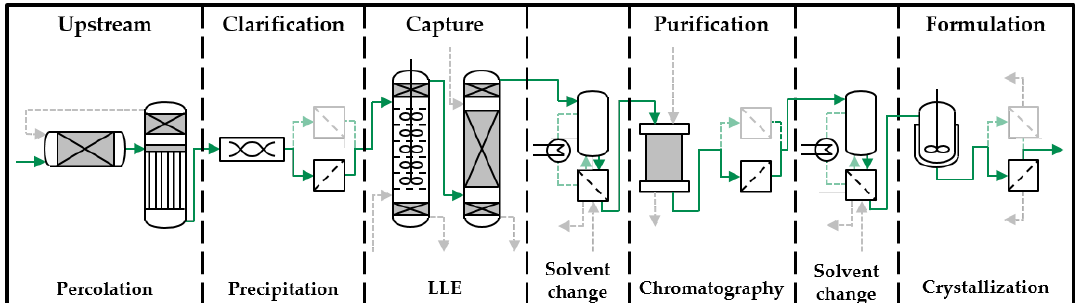
Figure 1. Basic process design for plant based substances (LLE, liquid-liquid extraction) [6].